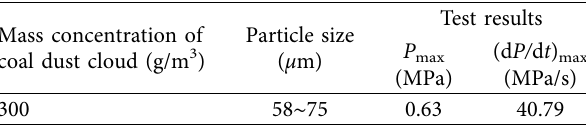
Figure 5: Flame propagation distance at diferent times. Table 3: Test results of nonstick coal dust explosion pressure